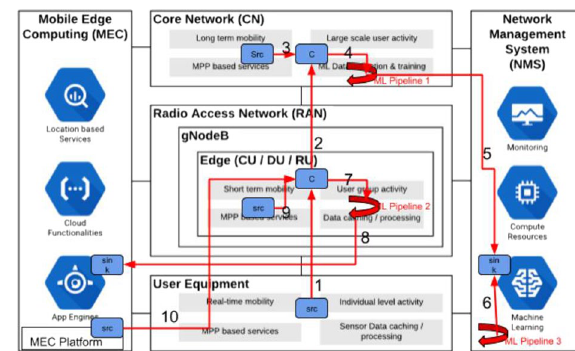
Fig. 4 Hosting of multi-level ML pipeline in 3GPP, MEC